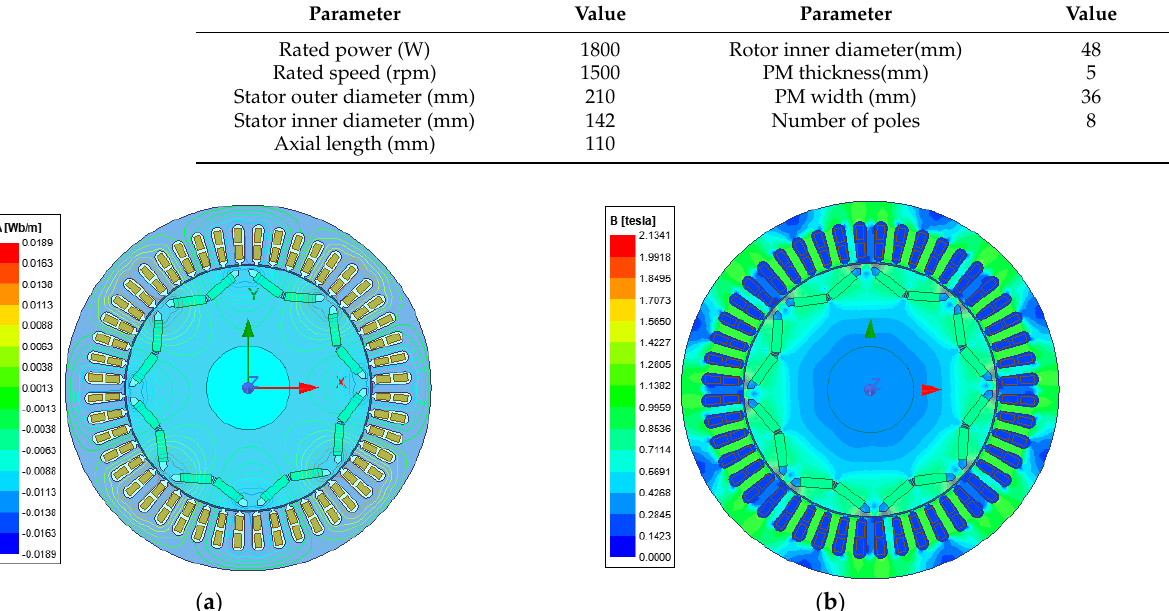
Figure 1. IPMSM FEM model. ( a ) Magnetic flux of IPMSM. ( b ) Magnetic field density of